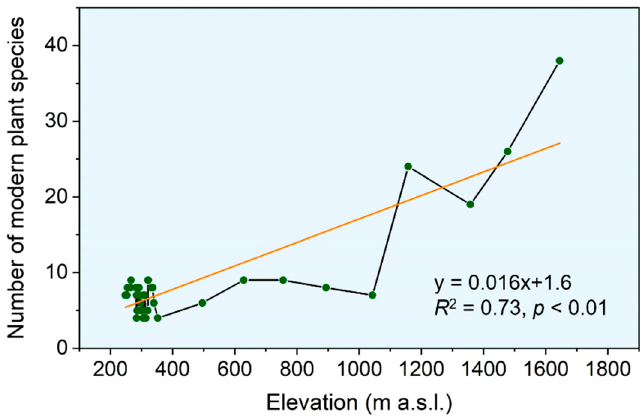
Figure 2. The richness of modern plant species along the elevational gradient. The orange line represents the linear regression line.